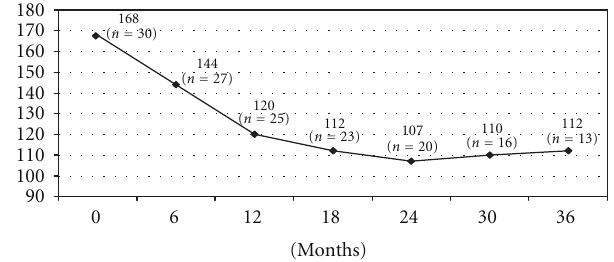
Figure 4: Weight evolution